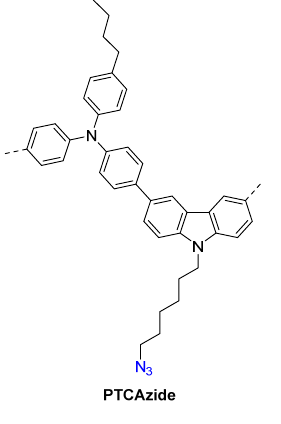
Figure 6. Chemical structure of (poly 4 ‐ (9 ‐ (6 ‐ azidohexyl) ‐ 9 H ‐ carbazol ‐ 3 ‐ yl) ‐ N ‐ (4 ‐ butylphenyl) ‐ N ‐ Figure6. Chemicalstructureof(poly4-(9-(6-azidohexyl)-9 H -carbazol-3-yl)-N-(4-butylphenyl)- N -phenylaniline) phenylaniline) (PTC).